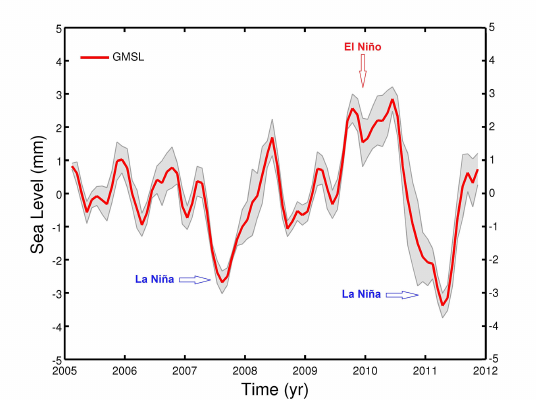
Fig. 1. Interannual GMSL over 2005-2011 based on the mean of the AVISO and Colorado University time series. The gray zone around the red curve represents the uncertainty based on the dispersion of each time series around the